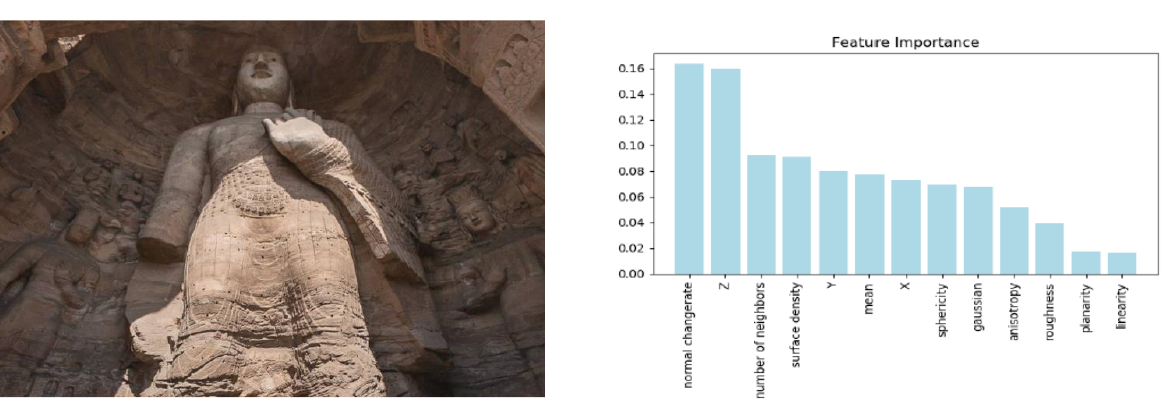
Figure 4. Feature importance statistics before feature selection